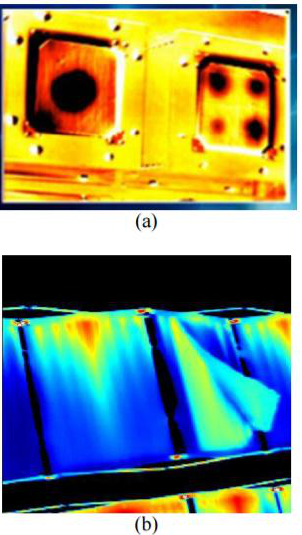
Figure 3. PT results obtained during EVA inspections of a CFRP component of the Space Shuttle ( a ) and a damaged ISS radiator ( b ), from 63.